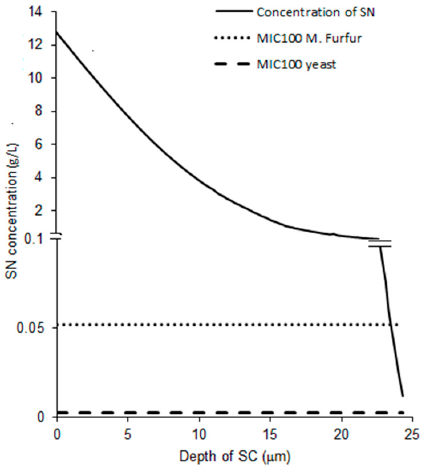
Figure 6. Simulated SN concentration across the SC plotted along with MIC 100 of M. furfur and yeast.